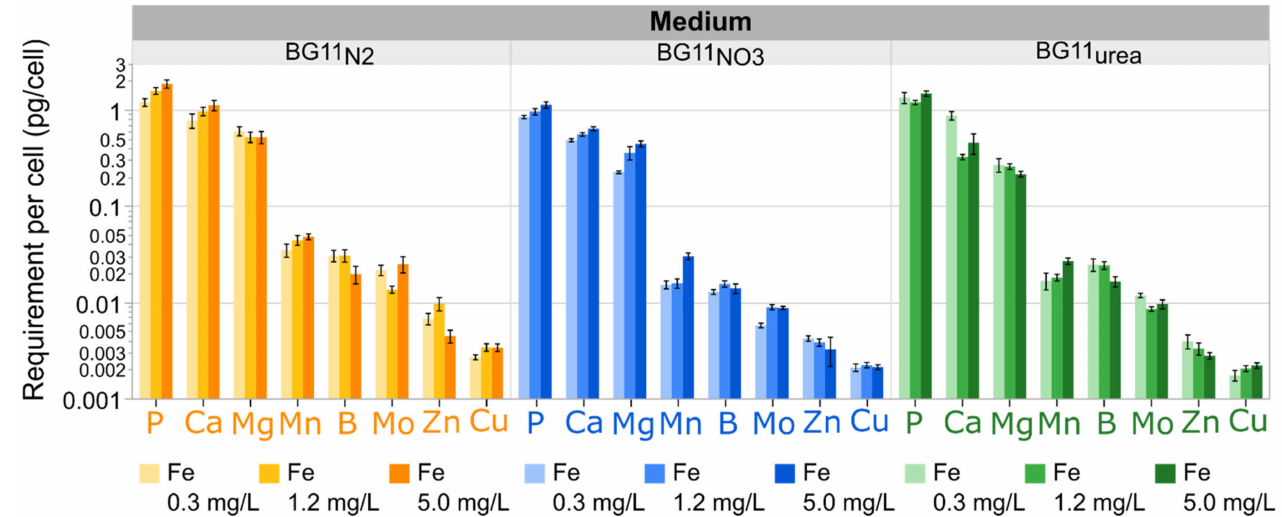
Figure 6. Ranking of mineral element demands per cell. Element demand are calculated based on the cellular production in the exponential phase. P, Ca and Mg are the most important inorganic nutrients, excluding C, Fe, and N-sources. These elements participate in ATP biosynthesis, cellular signaling and Chl a production. Mn is essential for photosynthesis and oxidative stress defense. B and Mo are more important for diazotrophic cells in BG11 N2 . Zn and Cu are involved in gene regulation and electron transfer through PSI, respectively. Each bar represents estimated requirements using the derivatives of nutrient consumption expressions with respect to cellular density (Table S8). Error bars represent the confidence fit interval of estimated demands with a significance level α = 0.05. Actual sizes of the error bars may differ due to the logarithmic scale on the Y-axis. Data represent results for three biological replicates per medium type and Fe level